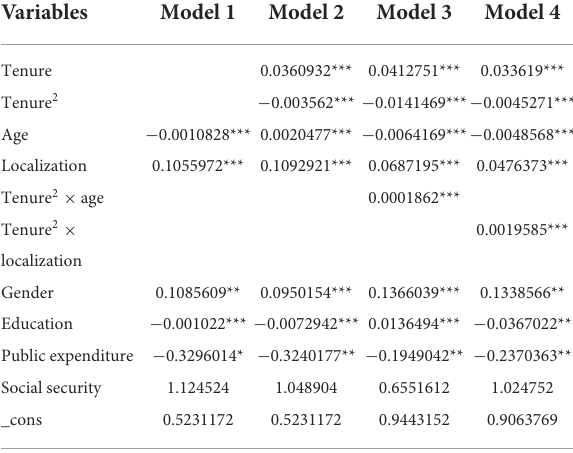
TABLE 4 Results of regression analysis based on CLAD